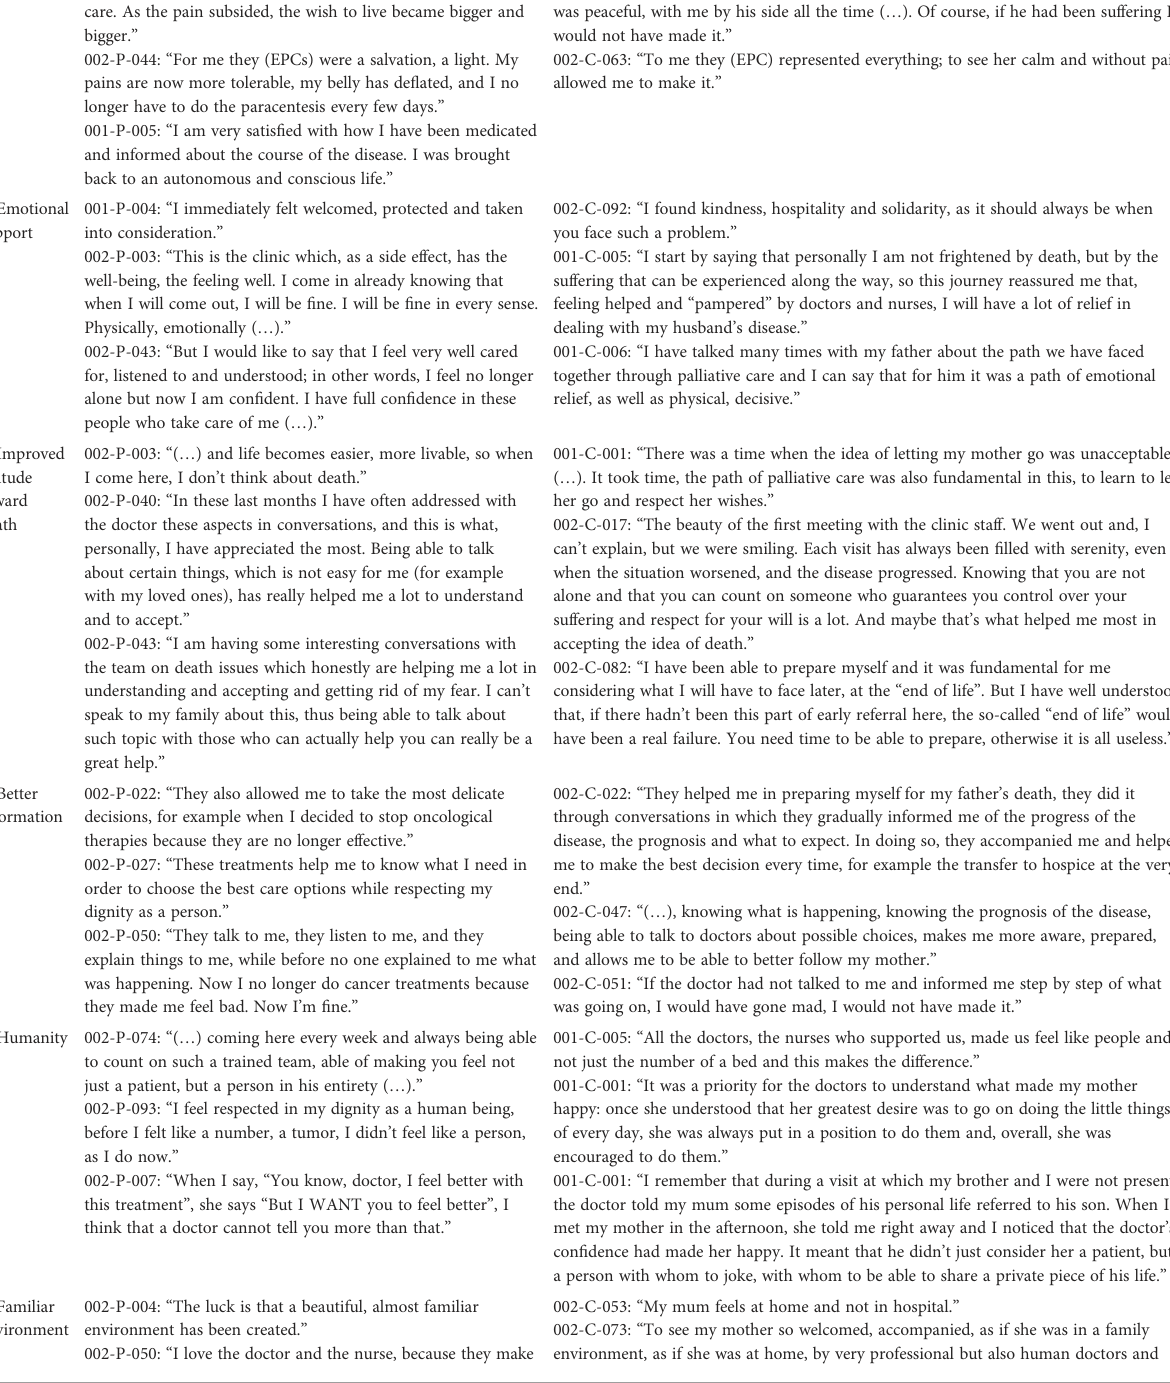
TABLE 5 Emerging reasons for gratitude and illustrative quotations from patients and caregivers. Reasons